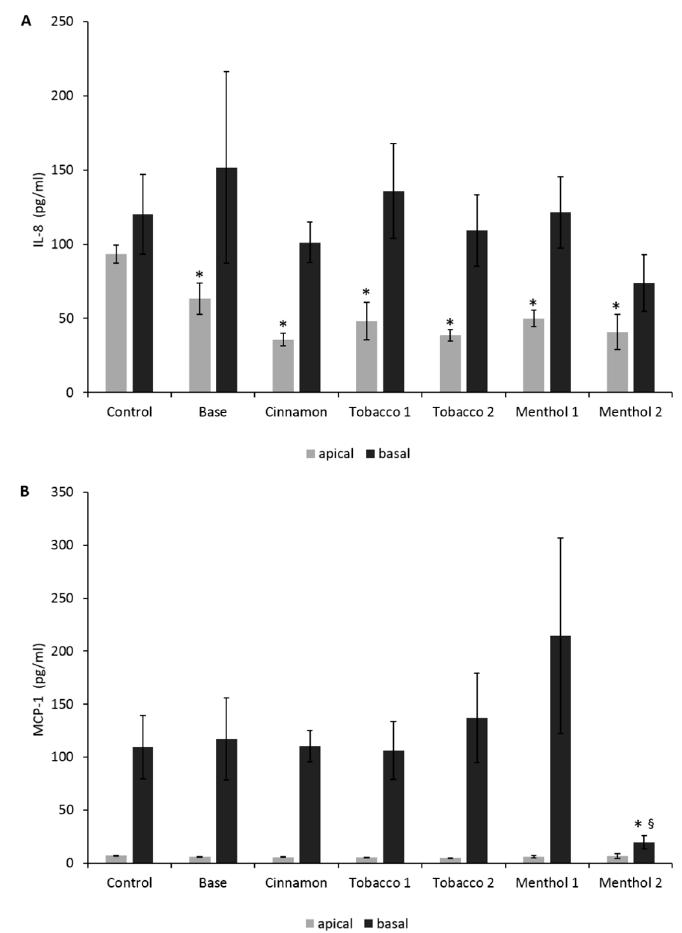
Figure 5. Pro-inflammatory cytokines release in the ABB model. ( A ) IL-8 release by the alveolar NCI-H441 cells (apical, grey bars) and by the endothelial lung microvascular endothelial cells (HPMEC) cells (basal, black bars); ( B ) MCP-1 release by alveolar NCI-H441 cells (apical, grey bars) and by the endothelial HPMEC cells (basal, black bars). Bars = pg/mL of IL-8 and MCP-1 released by co-cultures. Data are presented as mean±SEM of at least three different independent experiments. * p < 0.05; unpaired t -test over the control; § p < 0.05; unpaired t -test over basal Base 18.